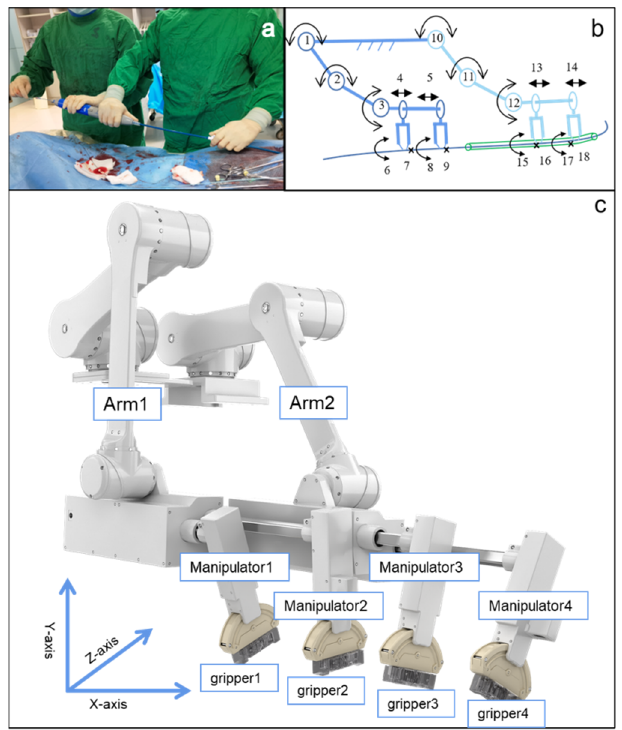
Figure 2. Bionic design of endovascular robotic system ( a ): the manual operation; ( b ): the illustration of bionic design; ( c ): Arm 1 and Arm 2 simulate the operator and assistant which can be moved in all the X, Y, and Z -axis directions. The manipulators simulate the hands of the operator which can be moved in the X -axis direction. The grippers simulate the fingers of the operator which can be rotated around the Z -axis plane.